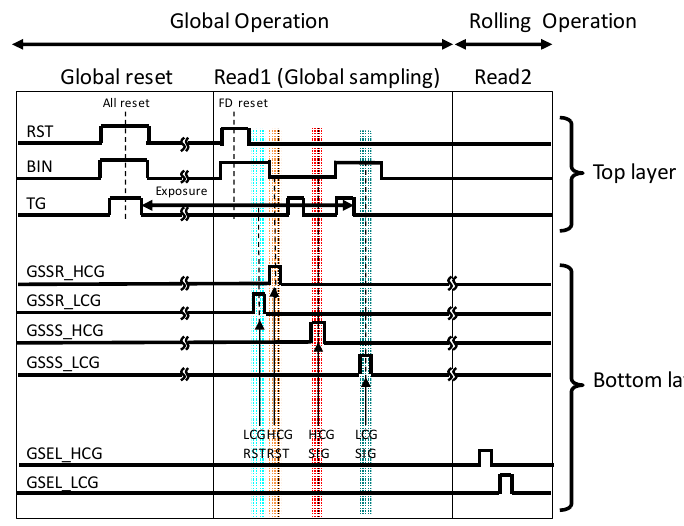
Figure 4. Timing sequence of the global shutter (GS) multiple gain readout operation.